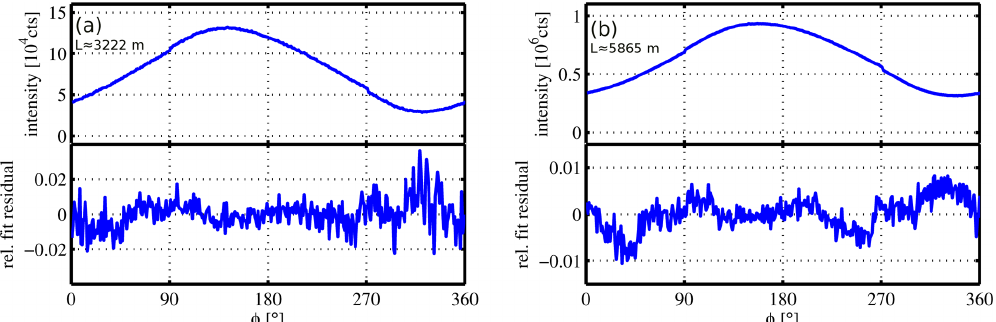
(cid:48) − 1 for modulation frequency